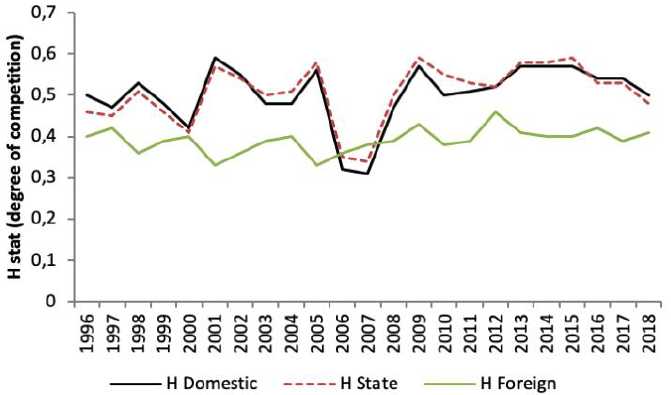
Figure 1: Time series behavior of bank